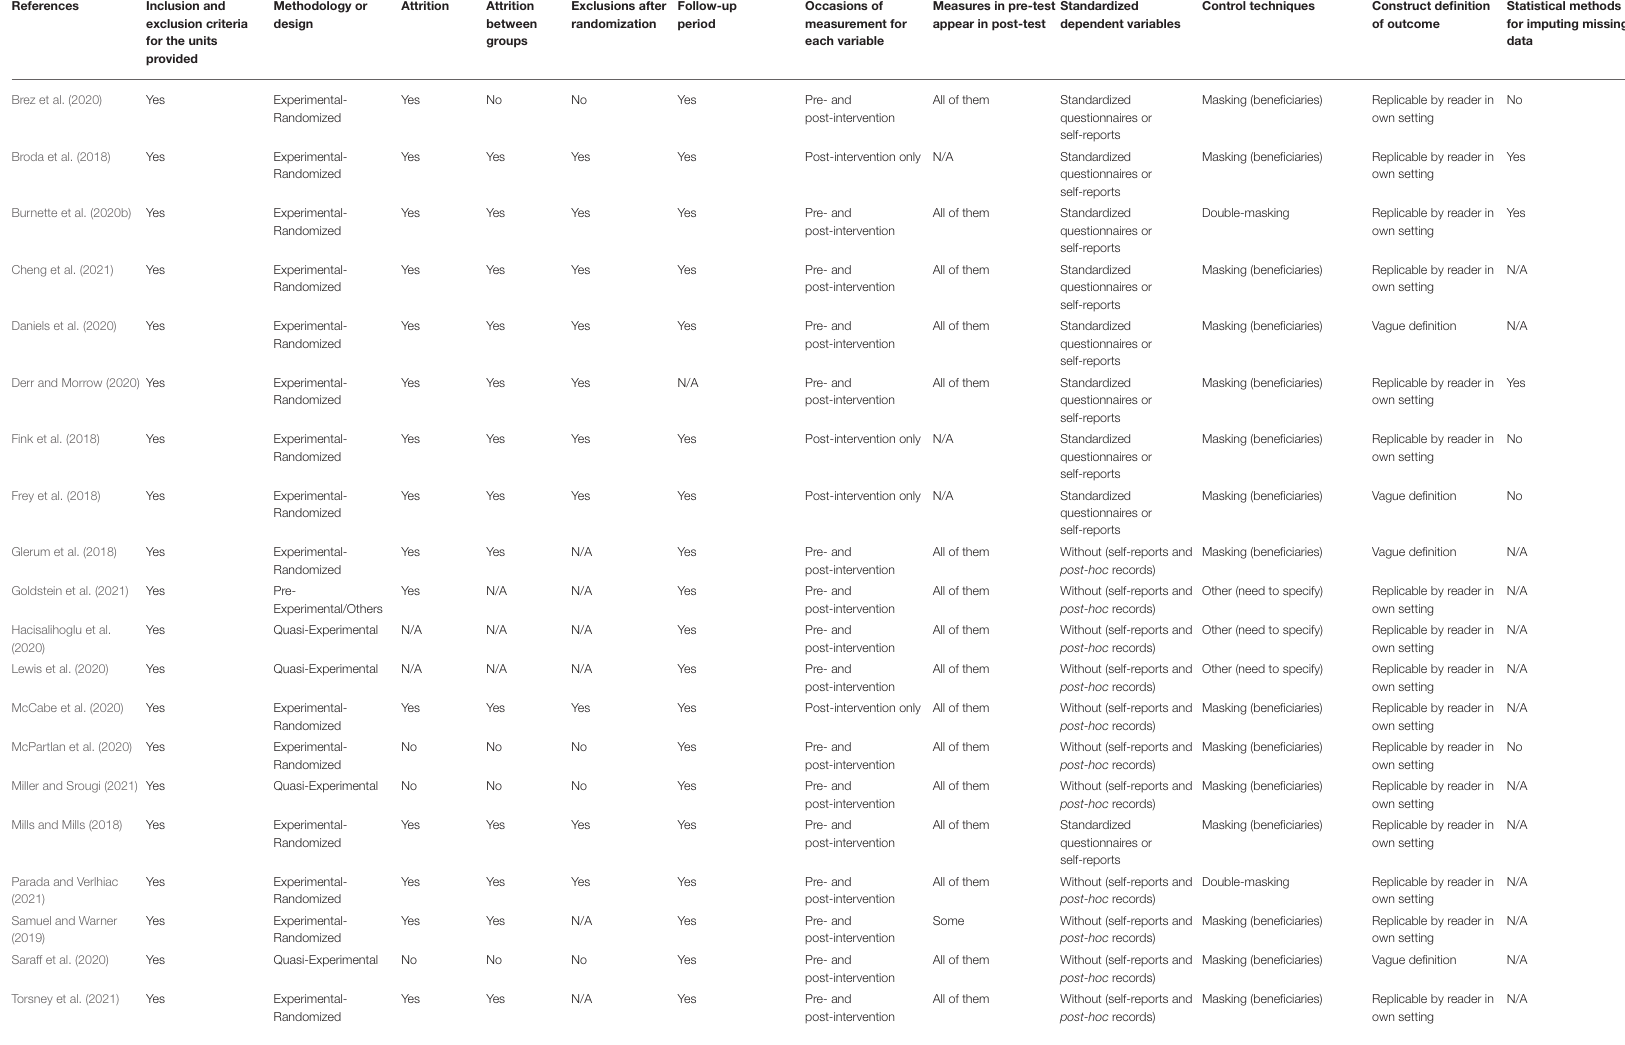
TABLE 3 | Methodological quality 12-item